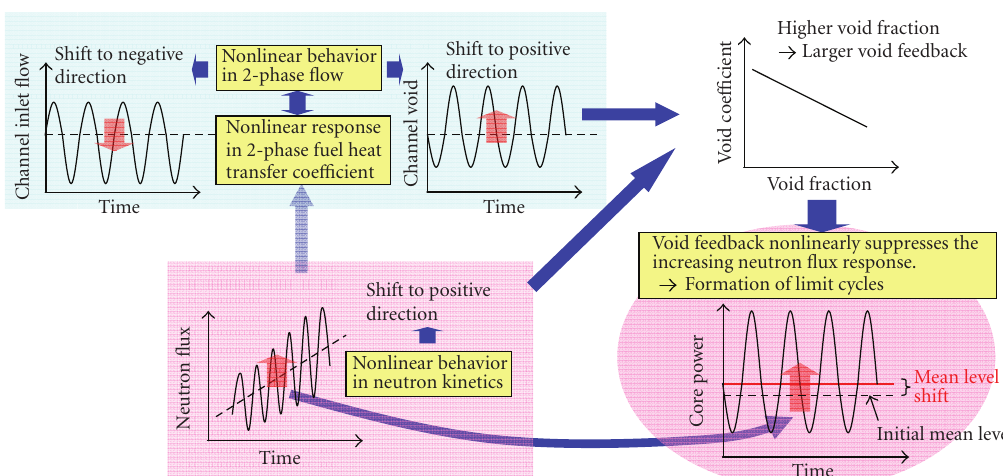
Figure 9: Mechanism in formation of limit cycle oscillations.